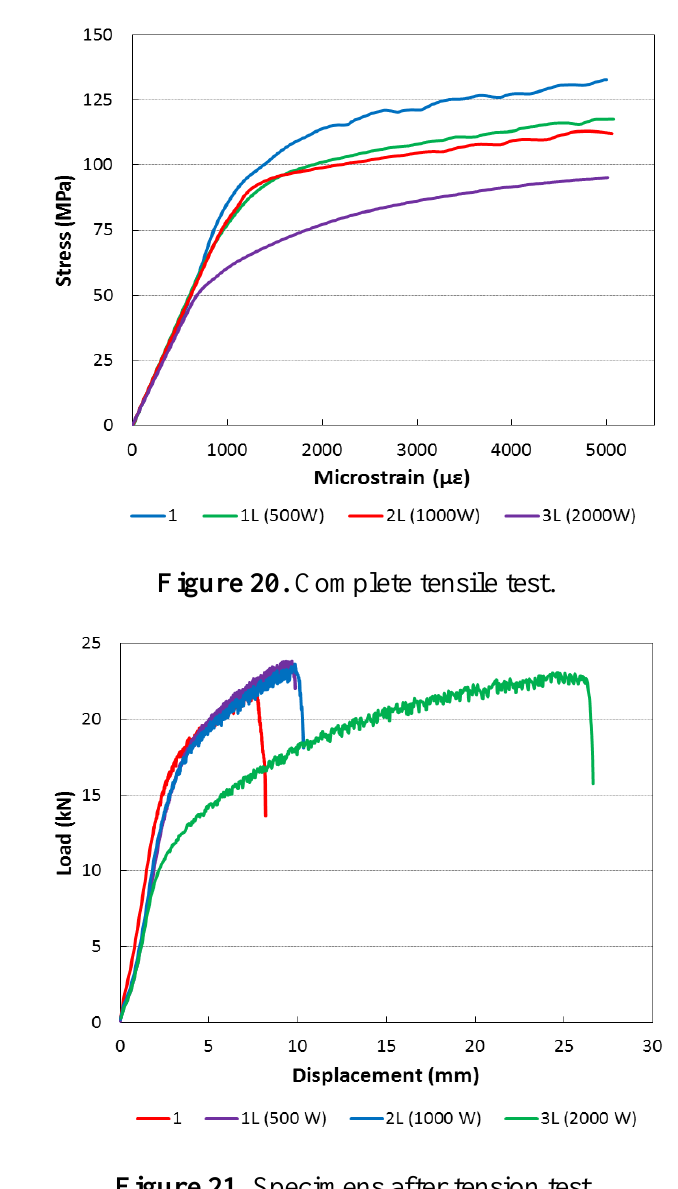
Figure 21. Specimens after tension